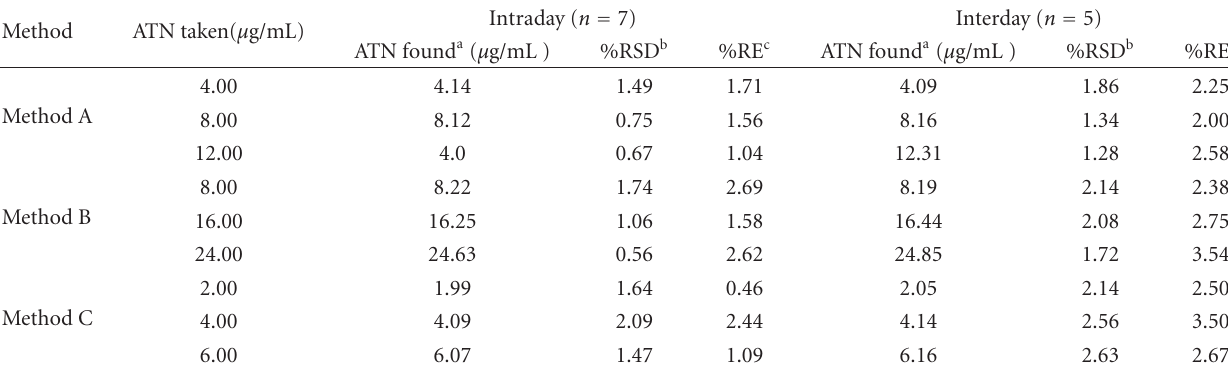
Table 3: Evaluation of intraday and interday precision and accuracy.